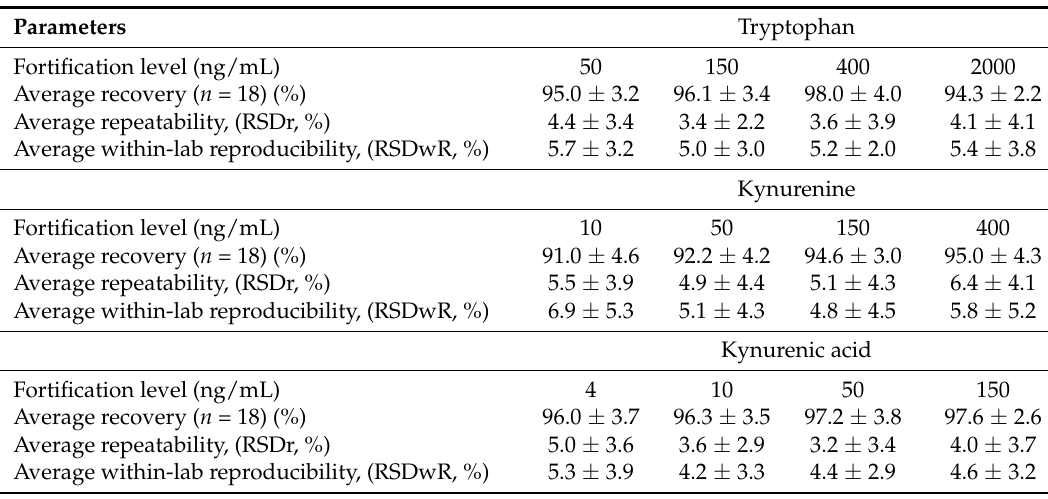
Table 3. Validation